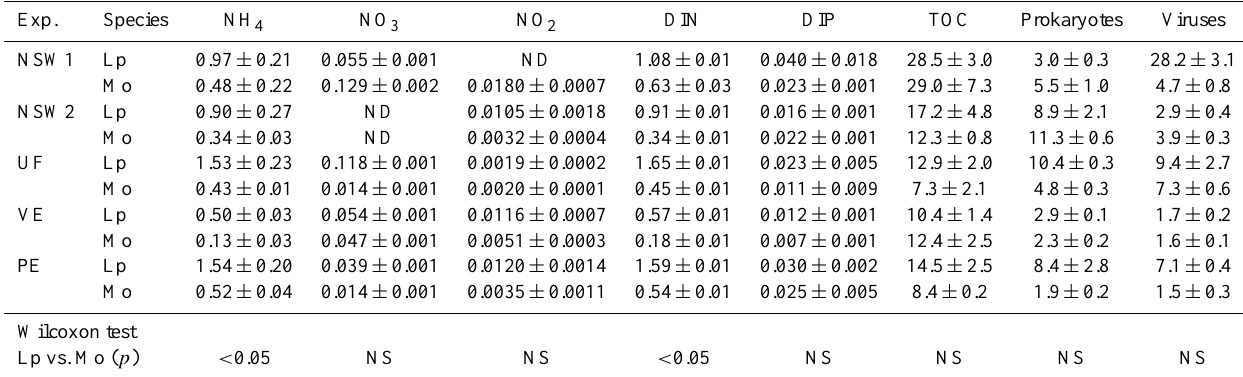
Table 4. Organic carbon release and stimulation of nutrients, prokaryotes and viruses in incubation water with corals (corrected for controls). For calculations see “Material and methods”. Nutrient parameters and TOC are given in mgm − 2 coral surface h − 1 , prokaryotes as 10 9 cells and viruses as 10 9 viruses m − 2 coral surface h − 1 . Data are given as averages ± SE of 3 replicates. NSW, natural seawater; UF, ultrafiltrate; VE, virus-enriched; PE, prokaryote-enriched; DIN, dissolved inorganic nitrogen; DIP, dissolved inorganic phosphorus; ND, not detectable (i.e. statistically not different from or lower than controls).